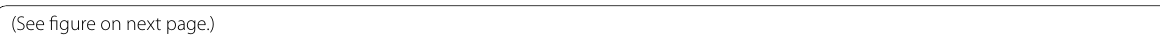
figure on next Fig. 3 Nhlrc2 FINCA/ − mice showed no morphological changes, neurodegeneration, or demyelination in the brain. a Upper: Representative image of 32-week-old female Nhlrc2 FINCA/ − and Nhlrc2 + / + hippocampal section stained with Luxol fast blue. Lower: a higher magnification showed no neurodegeneration in the dorsal hippocampus. b Upper: Representative image of 32-week-old male Nhlrc2 FINCA/ − and Nhlrc2 + / + cerebella. Lower: Higher magnification of the area inside the red box showing normal granule and Purkinje cells (black arrow). c Dot blots showing brain weight after fixation; area of the hippocampal section and thickness of corpus callosum measured from the midline. Individual datapoints, means and SEM are shown. There were no significant changes (Student’s